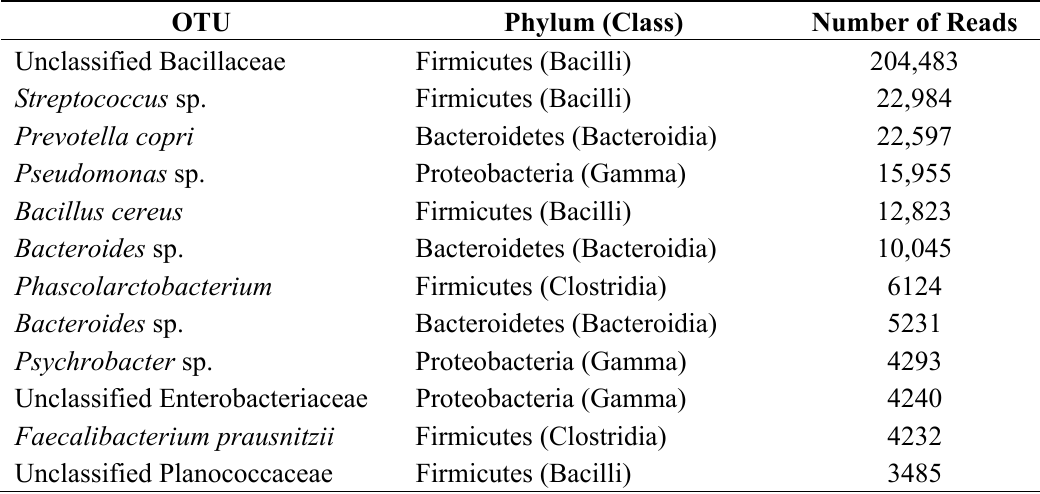
Table 2. Identities of the most prevalent bacterial populations (OTUs) associated with prepackaged fresh herbs (basil, chives, dill, mint, rosemary, thyme) sampled from a grocery store in Mississippi, USA, as determined from high throughput 16S rRNA gene sequencing. Number of reads represents the total number of sequence reads identified as that taxon, out of a total of 392,272